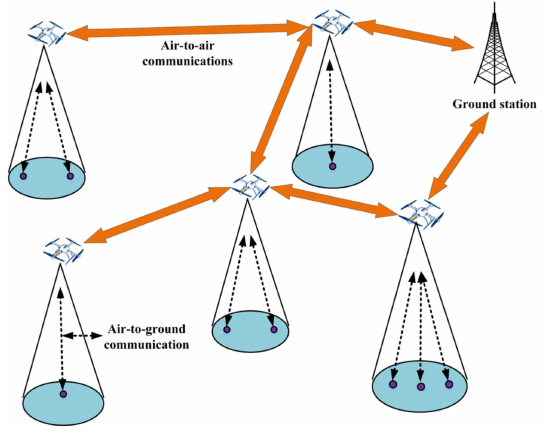
Figure 6. Multi-tier UAWSN